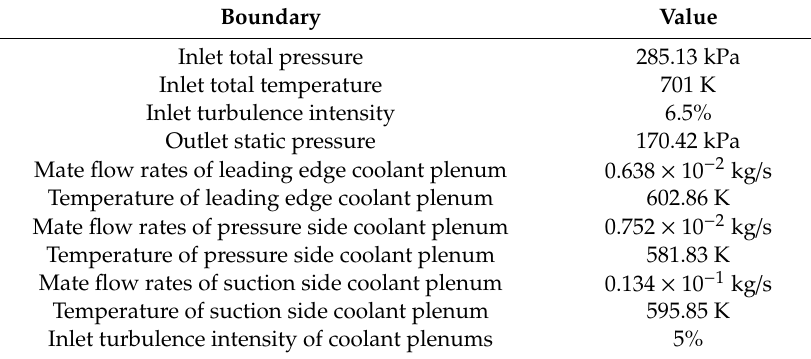
Table 2. Boundary conditions [17,18].